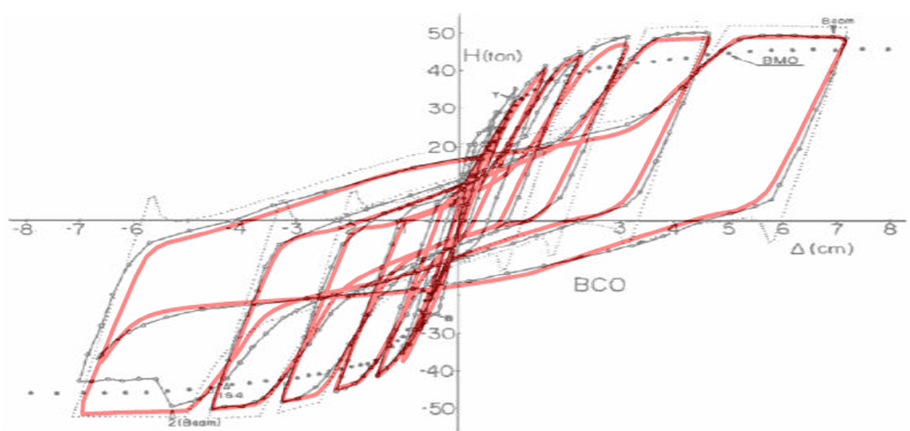
Figure 11. Comparison between the results of the numerical model implemented with SAP2000 (red continuous line) and the experimental test (BC0 curve—black continuous line; background image taken from [12]).